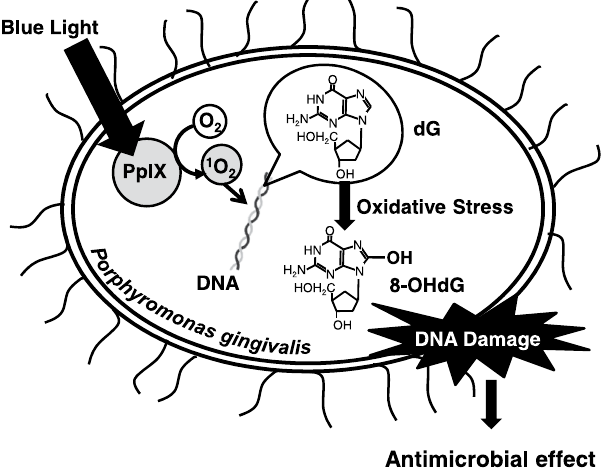
Figure 6. Blue light irradiation-induced antimicrobial mechanisms via protoporphyrin IX (PpIX) in Porphyromonas gingivalis